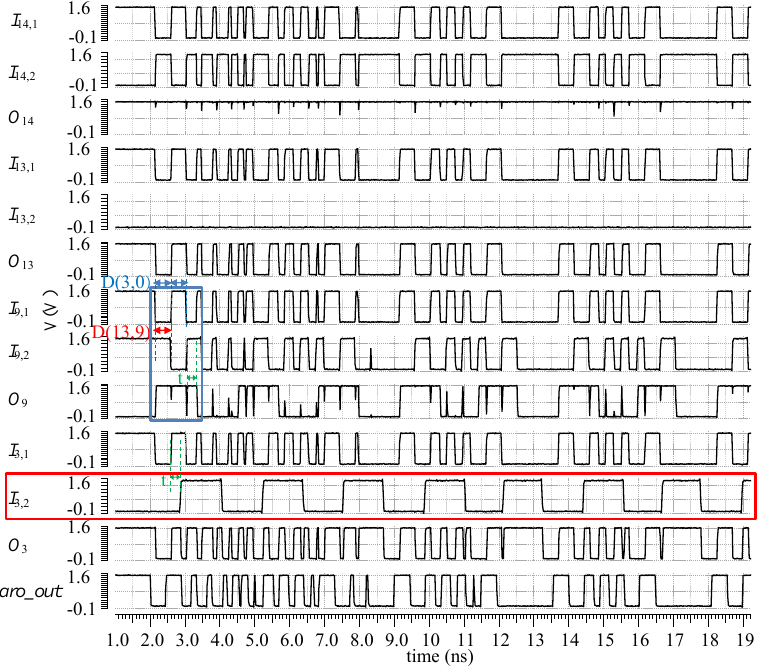
Figure 15: The simulated waveforms with feedback polynomial f ( x ) = x 15 + x 14 + x 13 + x 9 + x 3 +